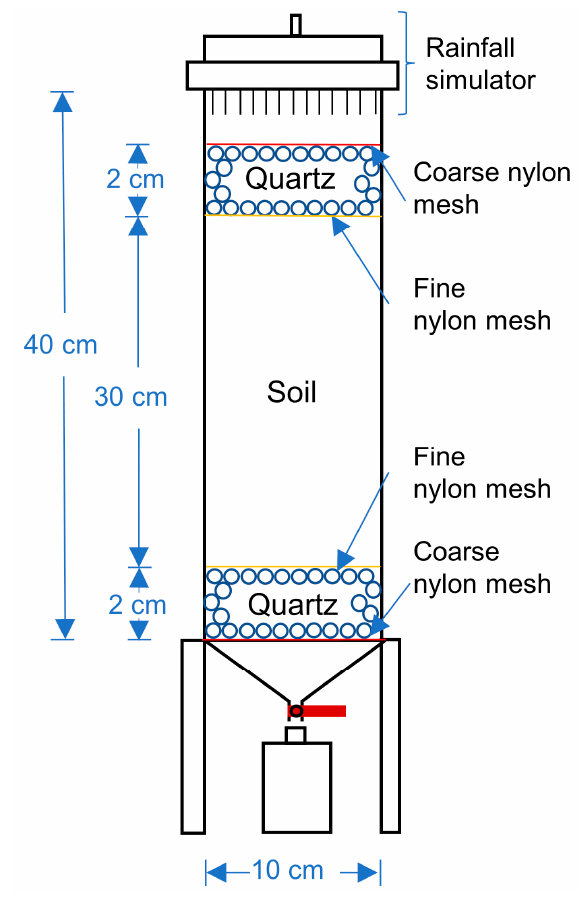
Figure 1. Schematic diagram of soil column structure.